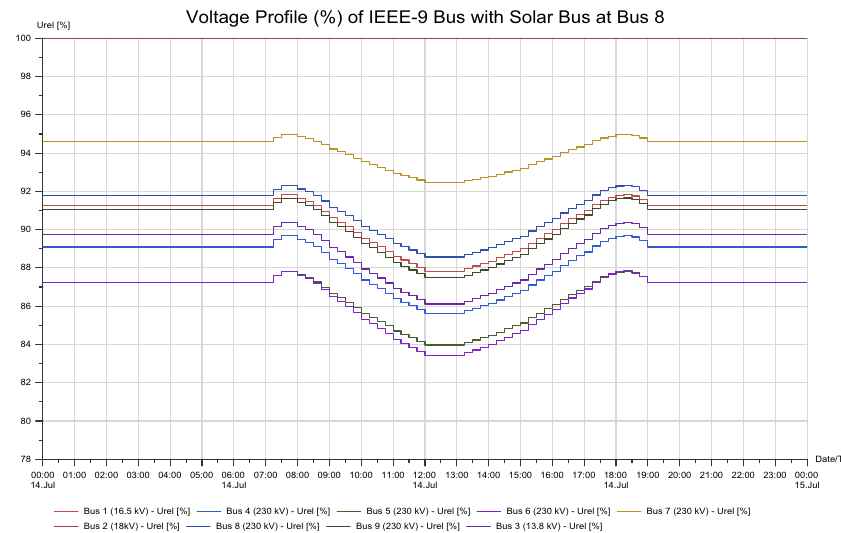
Bus 1 (16.5 kV) - Urel [%]